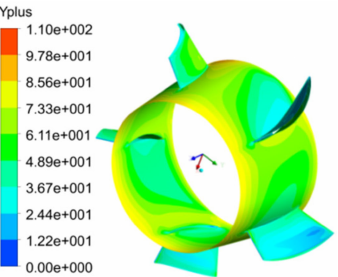
Figure 3. Yplus distribution on the impeller and